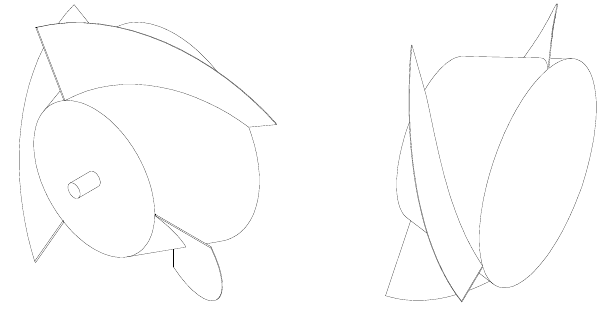
Figure 5. Screw-feeding stirrer.